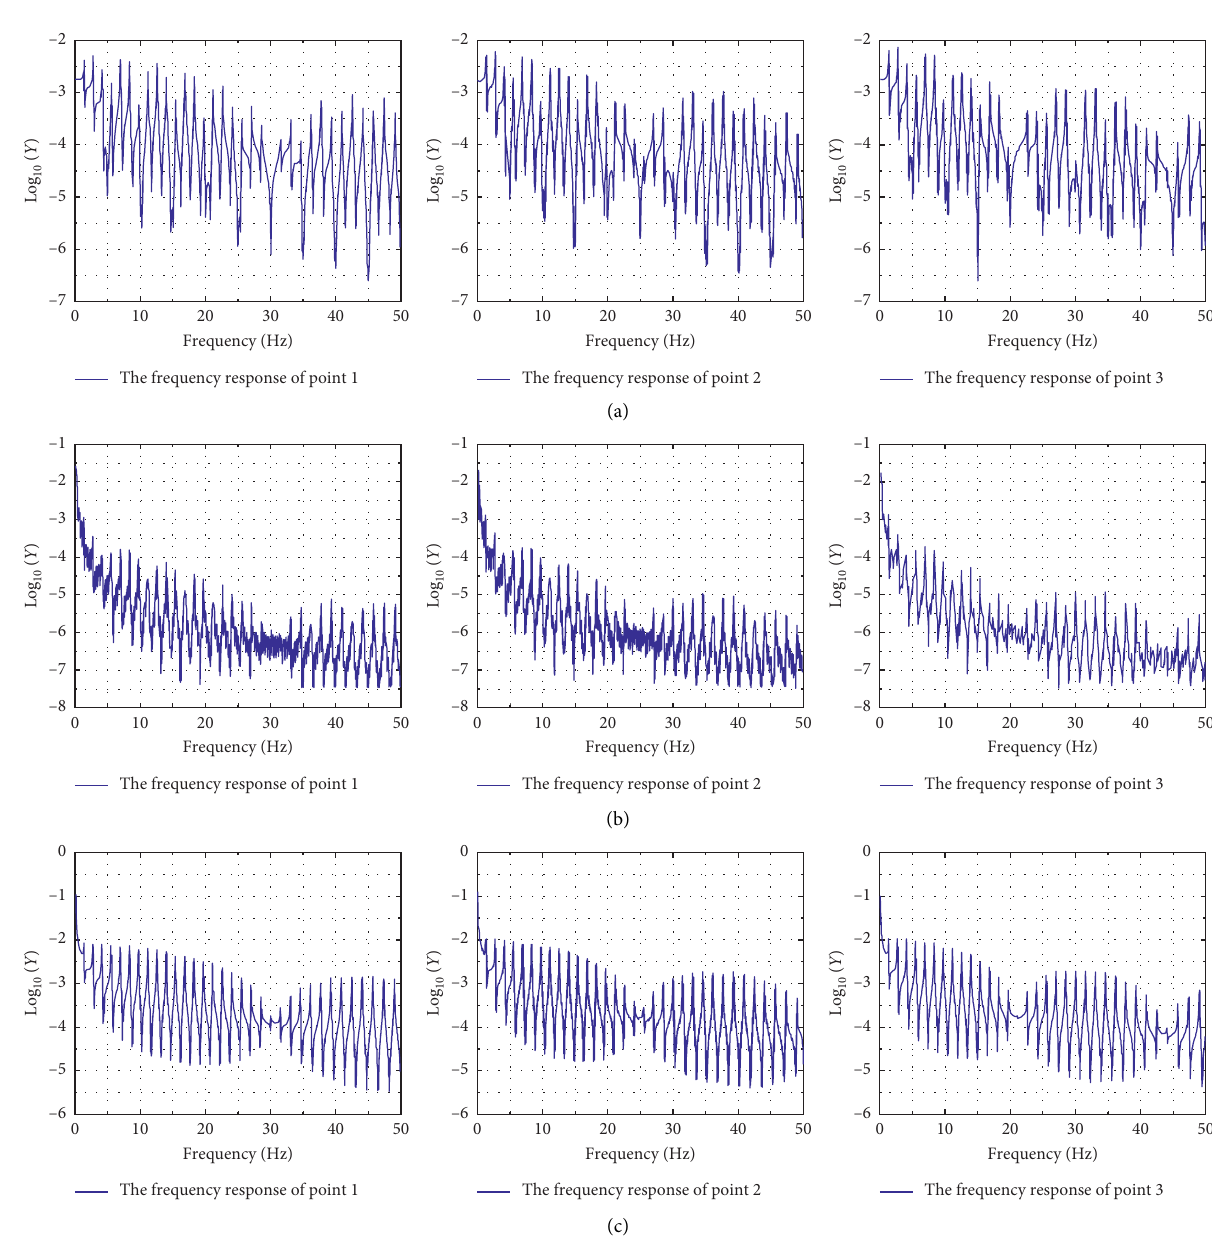
Figure 14: Frequency domain response of the measuring point under external load models: (a) case 1; (b) case 2; (c) case